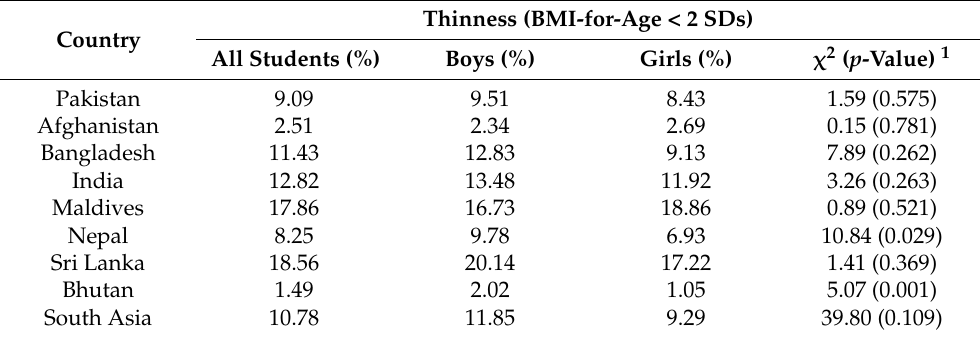
Table 3. Prevalence * of thinness among South Asian schooled adolescents aged 12–15 years.